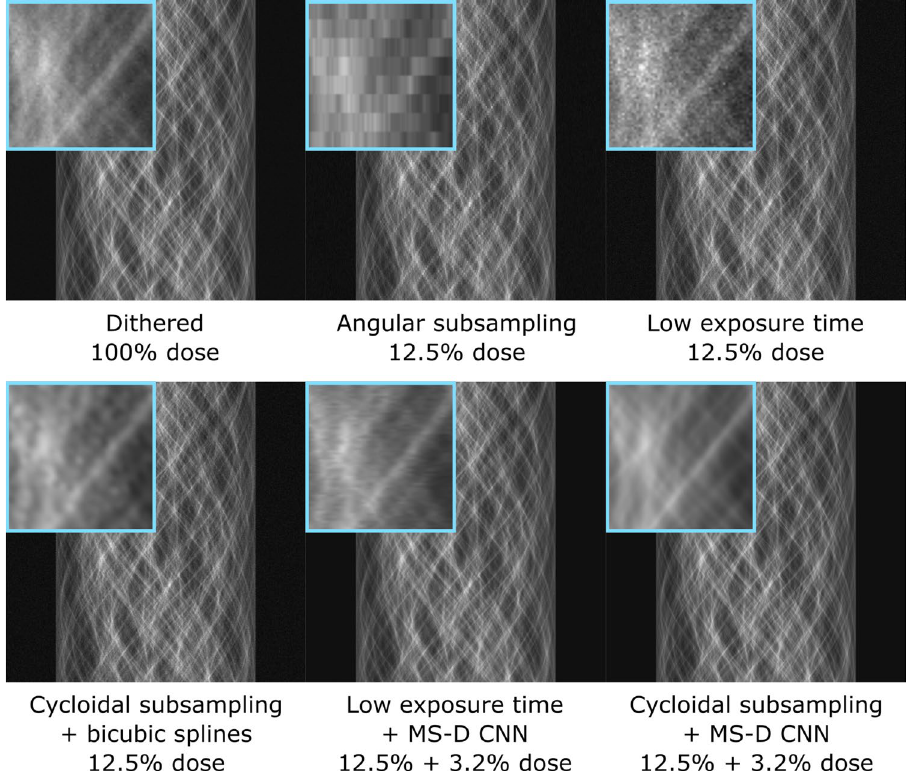
Figure 4. Simulated sinograms for the numerical foam sample, from left to right and top to bottom: complete sinogram, angular subsampling, low exposure time, cycloidal subsampling and bicubic splines interpolation, low exposure time data with projection denoising using a MS-D CNN 44 , cycloidal subsampling and MS-D CNN data